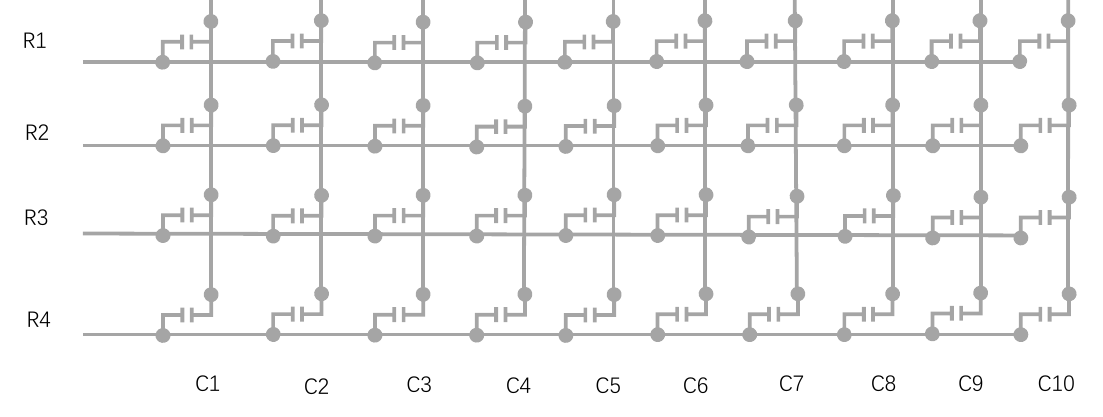
Figure 6. The schematic diagram of the force-pad.